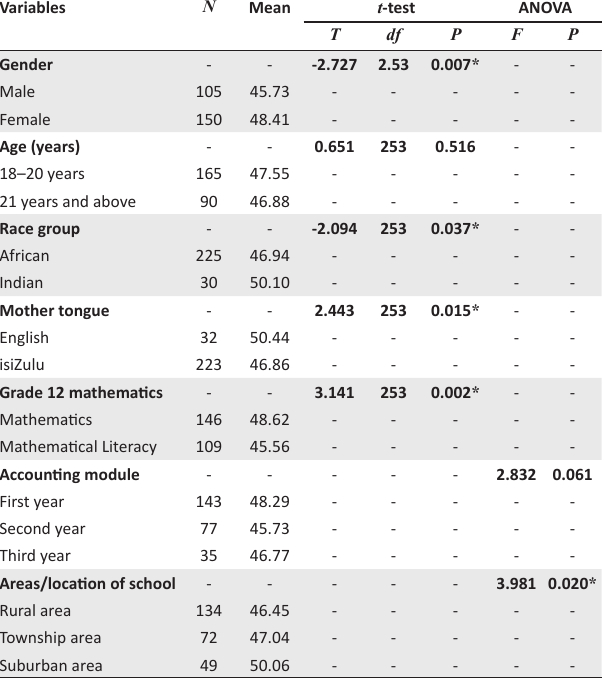
TABLE 9: Comparison: perceived support of teacher with demographic variables using means, t -test and ANOVA. Variables